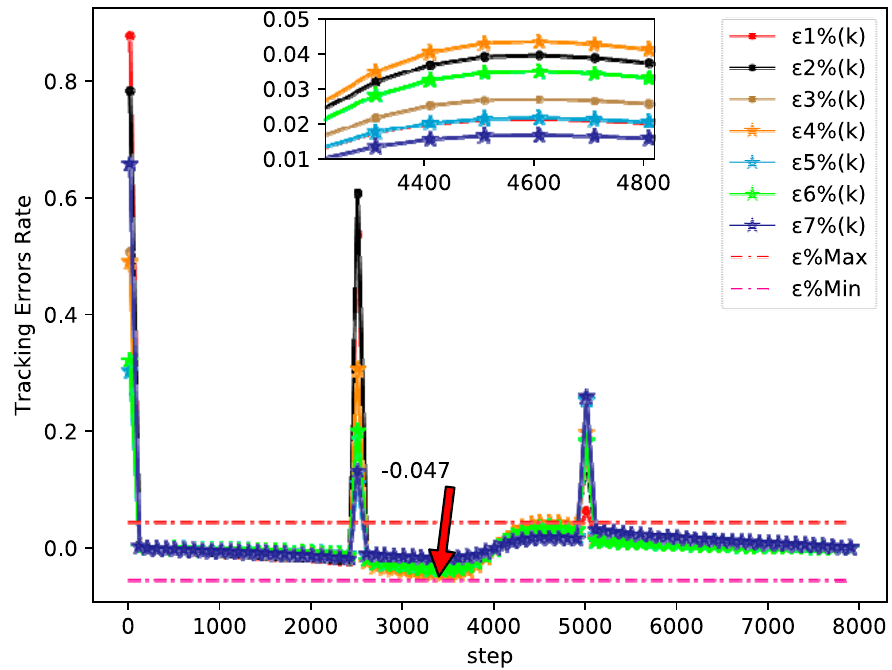
Figure 9. Tracking errors rate of each agent at Ψ = 500 (example 2).